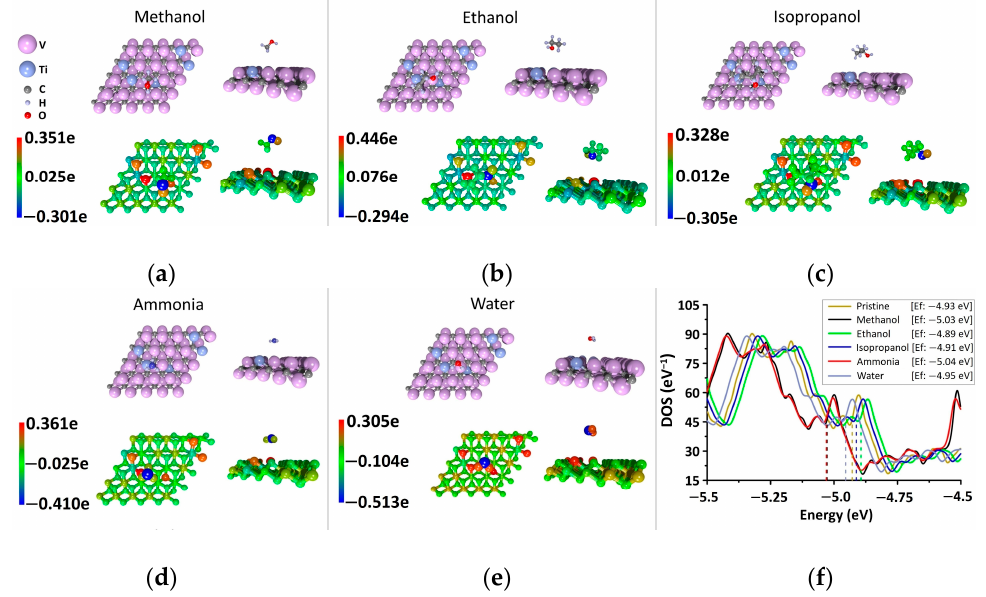
Figure 5. The DFT modeling of charge state for interaction between Ti 0.2 V 1.8 C and analyte molecules: ( a ) case of methanol; ( b ) case of ethanol; ( c ) case of isopropanol; ( d ) case of ammonia; ( e ) case of water; ( f ) density of electronic states in Ti 0.2 V 1.8 C under the analyte adsorption relative to Fermi level.